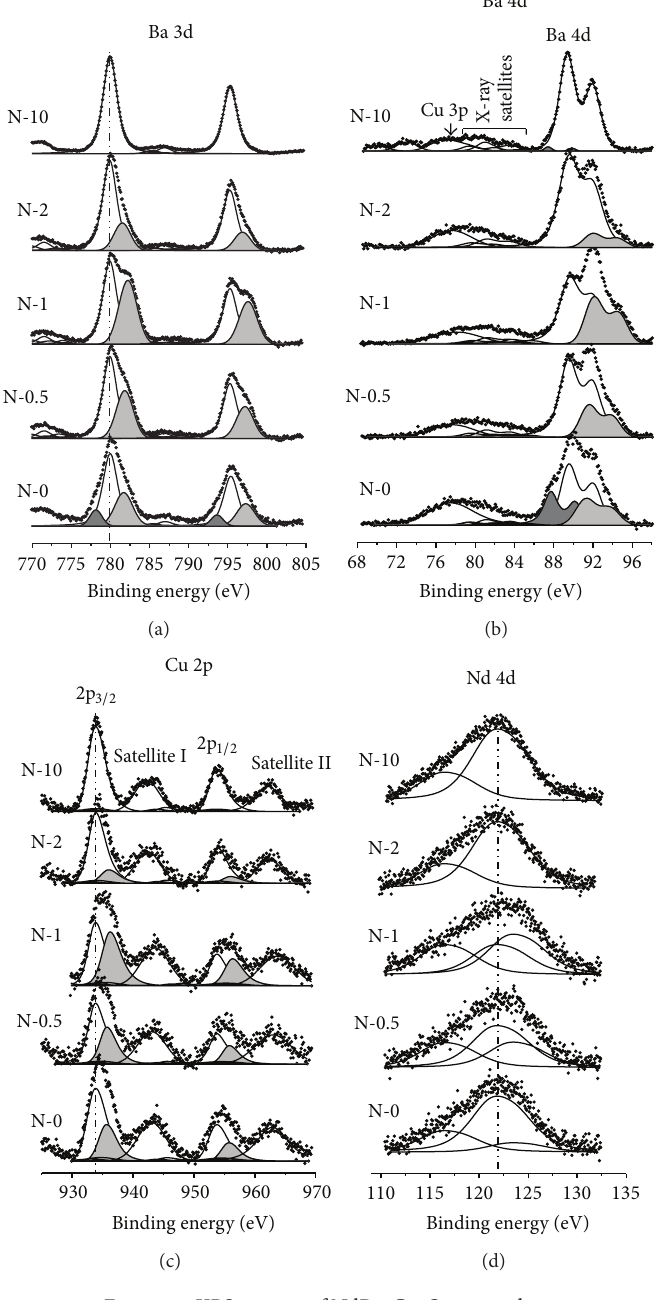
Figure 5: XPS spectra of NdBa 2 Cu 3 O 6+𝛿 powders.